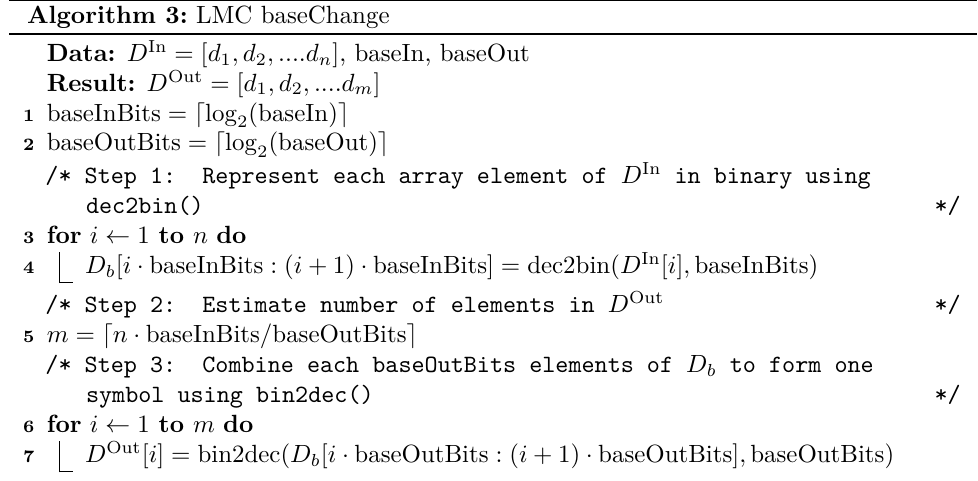
Algorithm 3: LMC